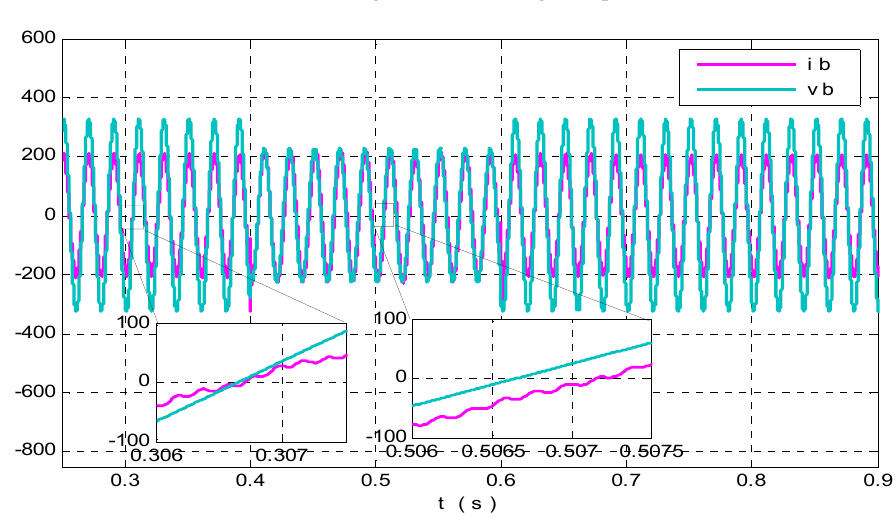
Figure 27. Voltage and current signals (phase b).